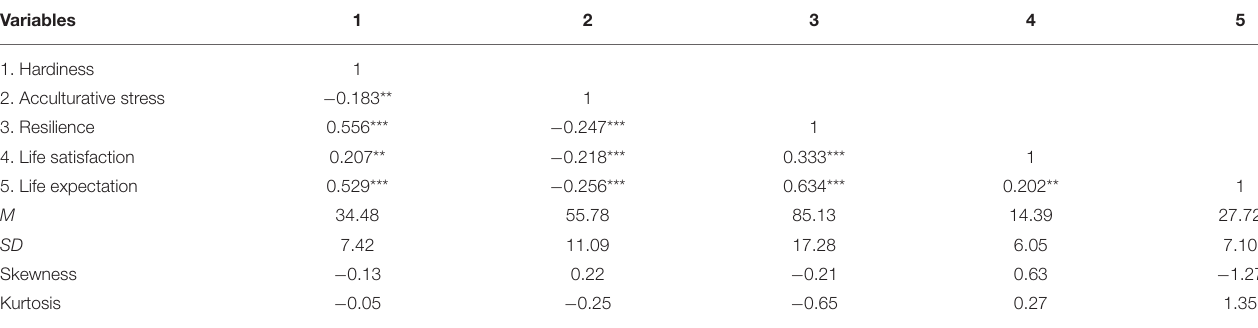
TABLE 2 | Correlational matrix of hardiness, acculturative stress, resilience, life satisfaction, and life expectation ( N = 201).